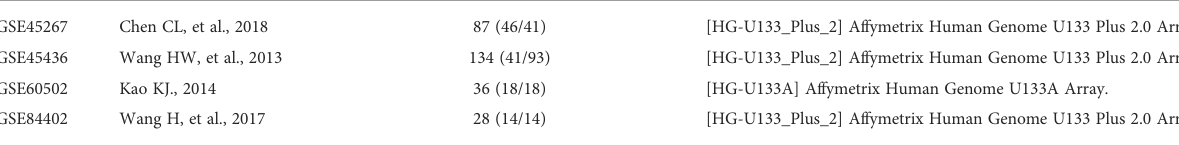
TABLE 1 Details of the GEO series included in this